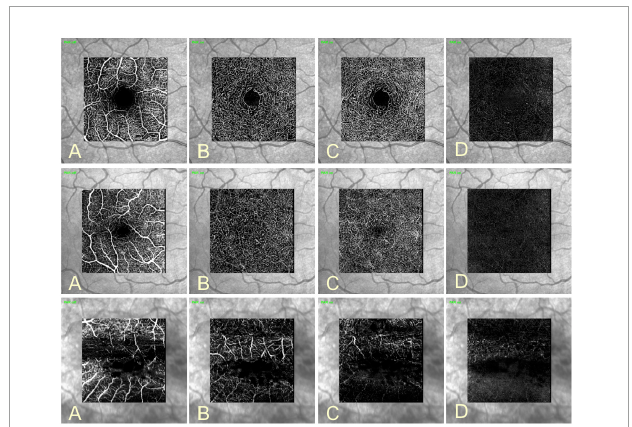
FIGURE2 Optical coherence tomography angiography (OCTA) images of a healthy right eye (upper row), ROP (middle row), and RVO (lower row). OCTA detects moving particles within vessels as intrinsic contrast and generates angiograms with depth resolved images of the retinal vasculature. With this method, the microvasculature of the superficial (A) , the intermediate (B) , the deep vascular plexus (C) and the avascular plexus (D) can be shown. Projection artifact removal (PAR) uses information of the superficial vascular plexus to remove artifacts from OCTA images. In the middle row the typical reduction in size of the foveal avascular zone in ROP patients can be seen. The lower row shows OCTA in RVO. Due to macular edema segmentation of retinal layers is aggravated with consequent displacement of retinal vascular